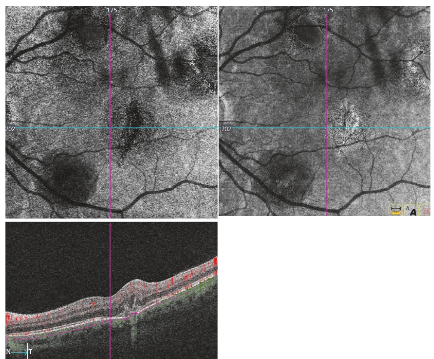
Figure1: Baselineexaminationofchoroidalrupture. OCTAshowsahyporeflectivelinecorrespondingtoretinalpigmentepithelium(RPE)- choriocapillaris defects near to the foveal area. B-scan reveals a disruption of the RPE-Bruch membrane and a hyperreflective intraretinal area associated with backscattering effect was also present.